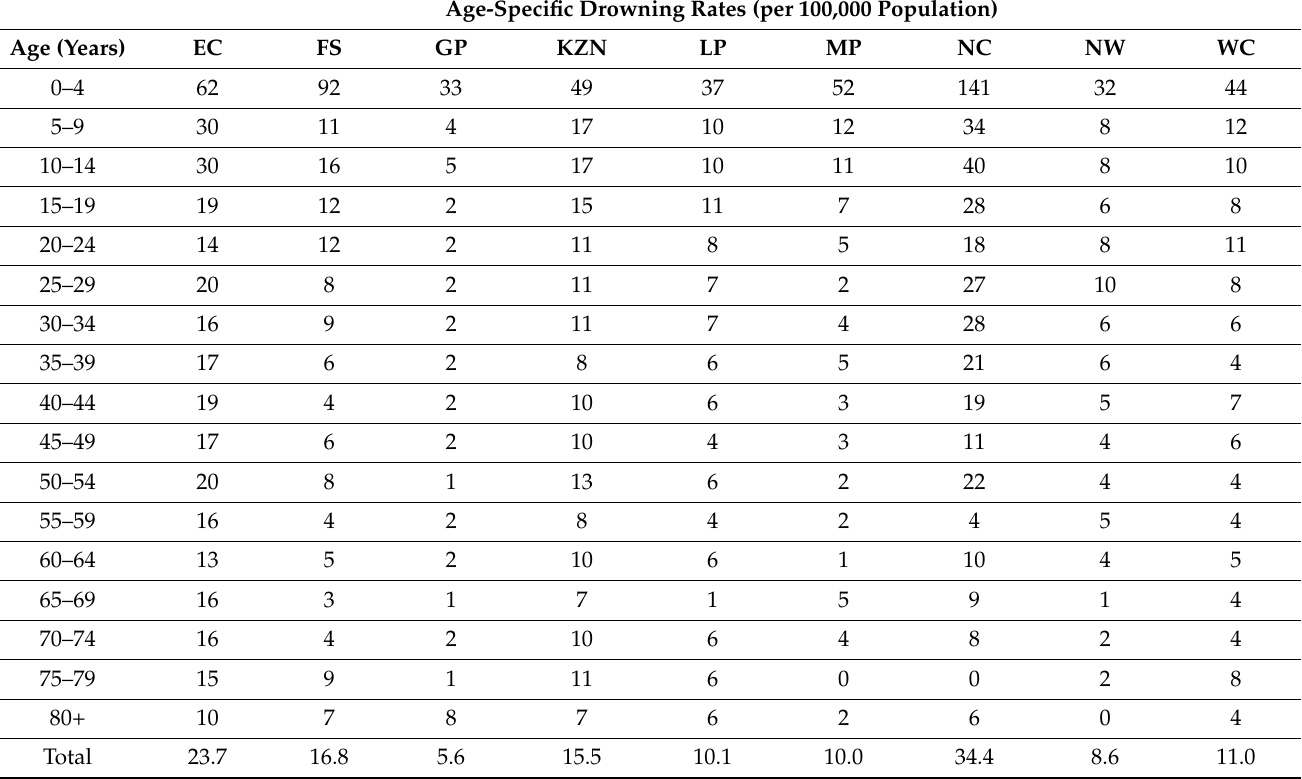
Table 5. Age-specific drowning rates per 100,000 population for South African provinces,